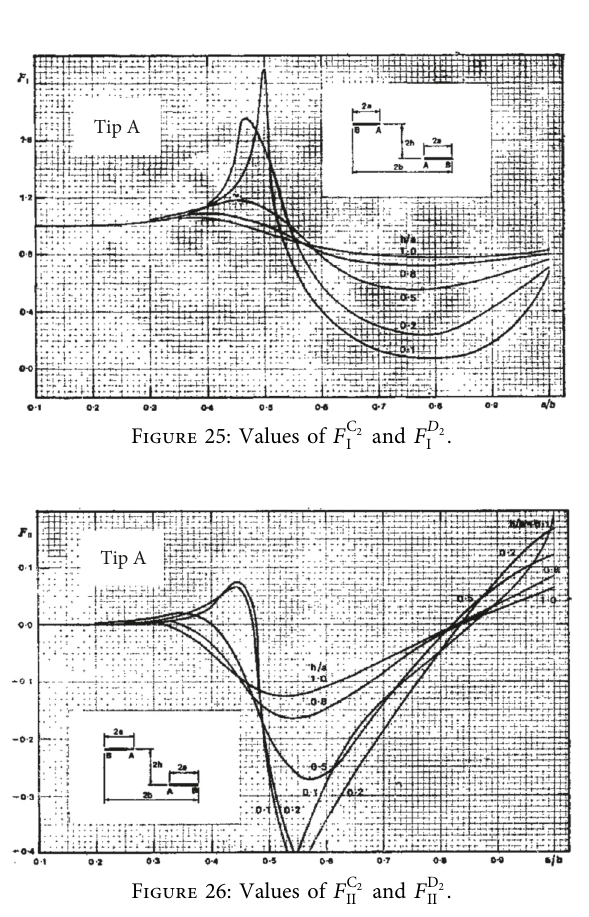
and F D 2 . ΙΙ ΙΙ